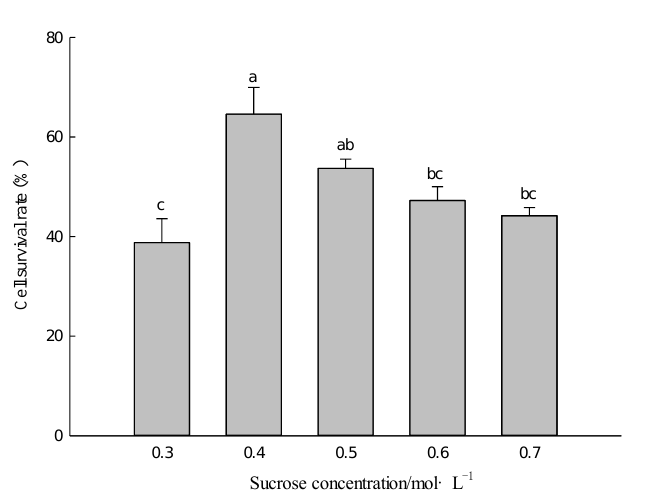
Figure 1. Effect of sucrose concentration on the survival percentage of F. mandshurica embryogenic callus after cryopreservation by the slow cooling method. Note: Lowercase letters represent significant differences at p < 0.05.